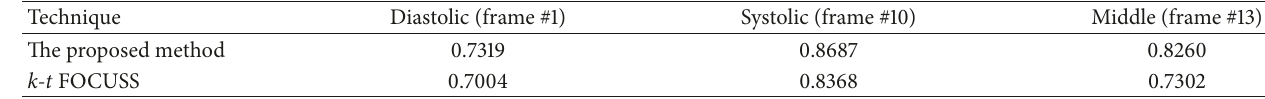
Table 1: SSIM comparison for the proposed method and k-t FOCUSS with MEMC.